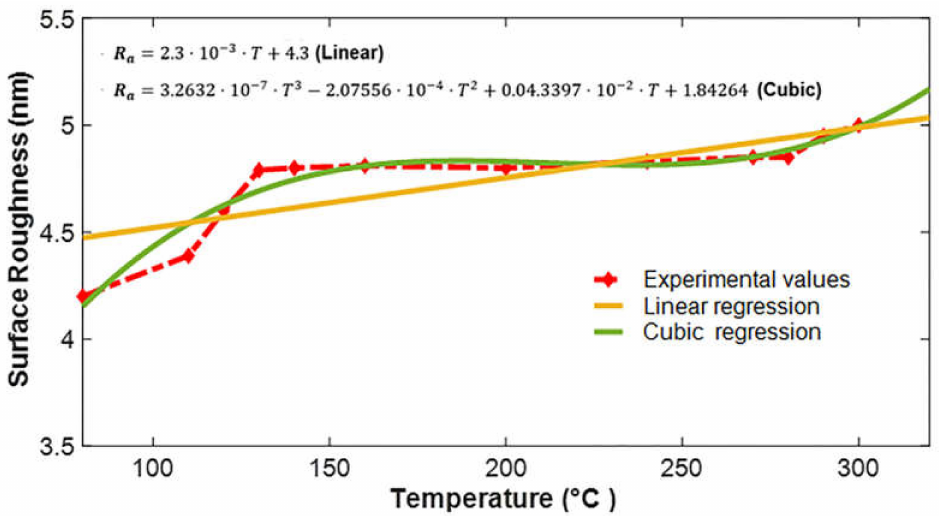
Figure 5. Graphical representation of the experimental data (dotted red) and analytical prediction model application of models based on linear regression (orange) and cubic regression (green).